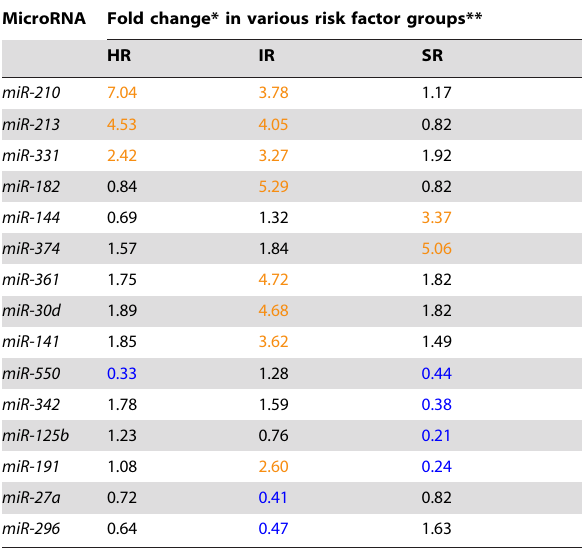
Table 5. MicroRNAs associated with risk categories in pediatric